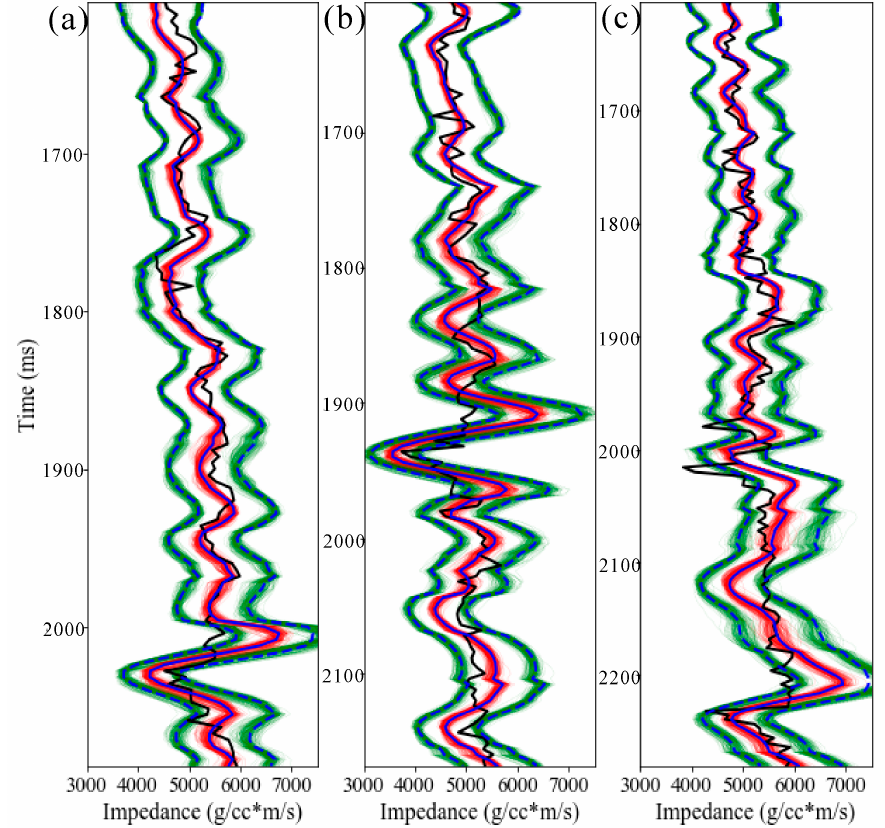
Figure 11. Inversion results at well ( a ) A08, ( b ) A13 and ( c ) A19. The black solid lines represent well- log data. The blue solid lines represent the final MAP model and the blue dotted lines represent the 0.95 confidence interval. The red lines represent the MAP model corresponding to 200 of 4900 wave- let and noise variance realizations.